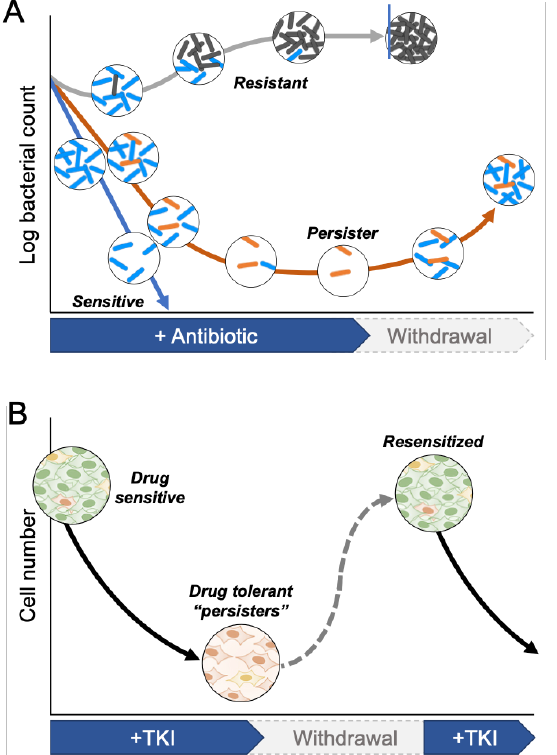
Figure 2. Conceptual similarities between bacterial and cancer persisters. ( A ) Survival curves depict bacterial state trajectories during exposure to antibiotics. Sensitive bacterial populations (blue) are eliminated by antibiotic treatment, whereas resistant bacteria (dark gray) continue to proliferate in the presence of antibiotic. Persister bacteria (orange) can survive during antibiotic exposure, but upon drug withdrawal, repopulate rapidly, proliferating sensitive bacterial populations. ( B ) Prototypical survival curve illustrating the emergence and reversibility of drug-tolerant cancer cells from a primarily drug-sensitive population. Treatment of heterogenous tumor cell populations with targeted therapy eliminates sensitive clones, revealing a subpopulation of so-called “drug-tolerant persister cells” (DTPs). A hallmark of the persister state is reversibility upon withdrawal of drug, resulting in re-establishment of a mixed population of sensitive and drug-tolerant cells.